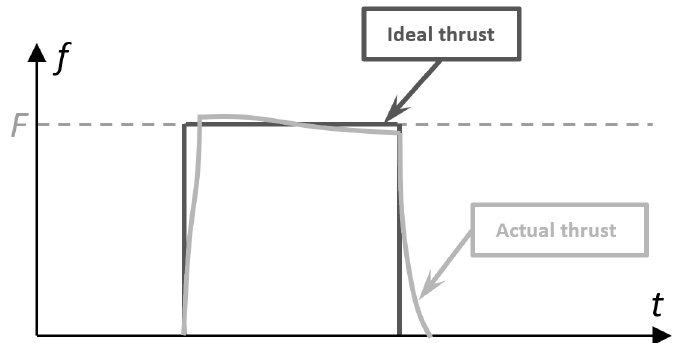
Figure 7. Thruster response at the beginning of its lifetime.